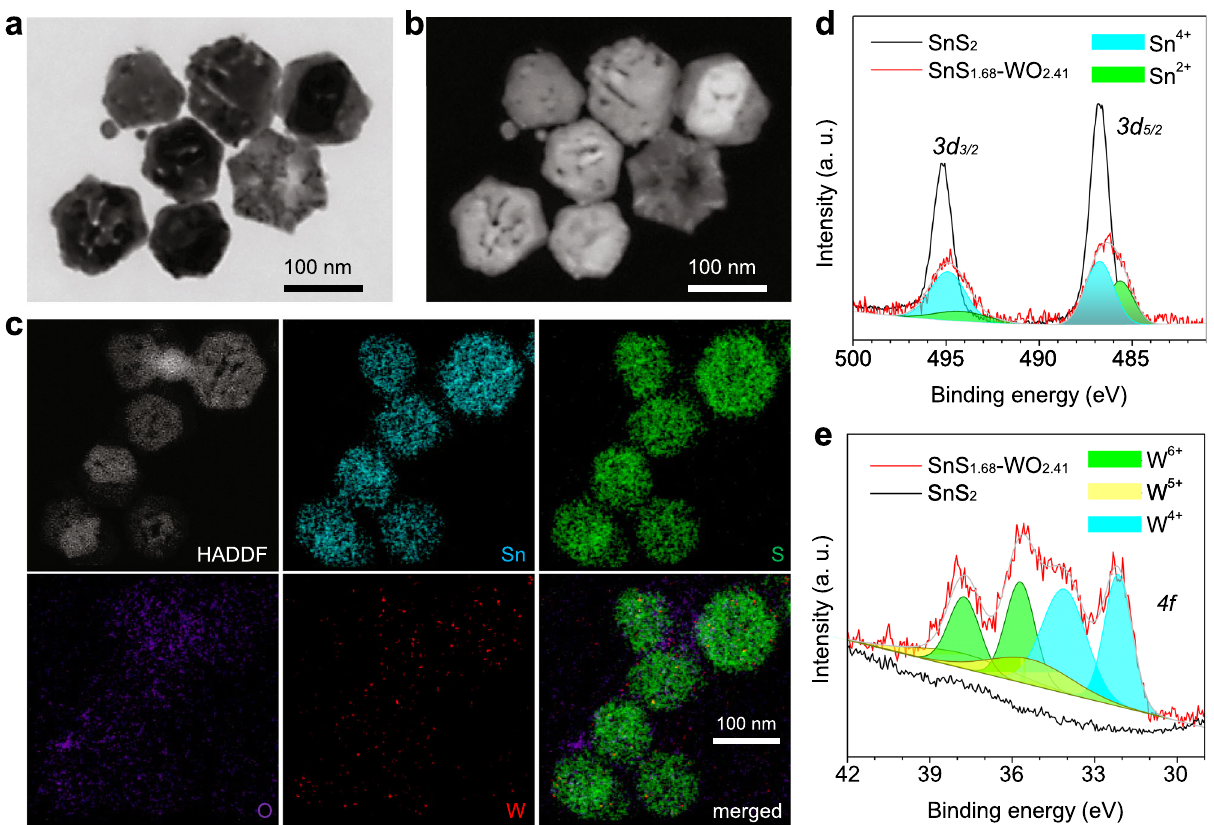
Fig. 2 Morphology, composition, and size characterization of the SnS 1.68 – WO 2.41 nanocatalyst. SEM ( a ) and corresponding STEM ( b ) images, HADDF image and corresponding elementary mapping ( c ), and XPS patterns ( d , e ) of the SnS 1.68 – WO 2.41 nanocatalyst. The experiments were repeated three times independently with similar